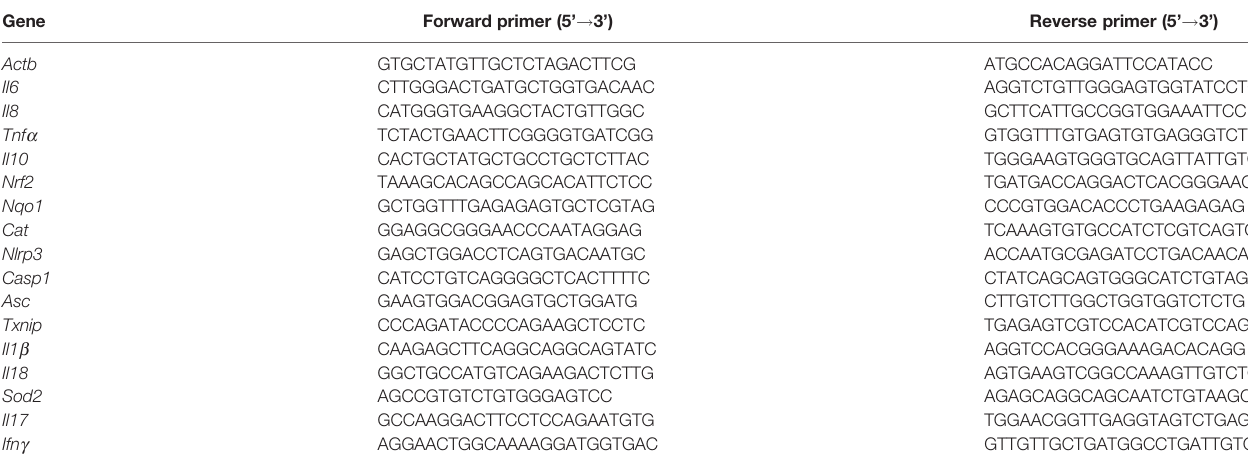
TABLE 1 | Primer sequence